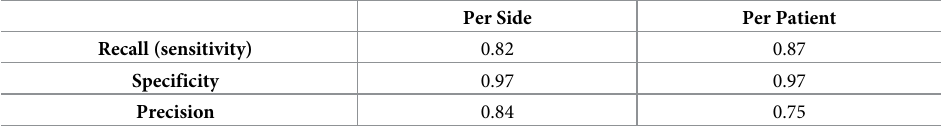
Per Side Per Patient